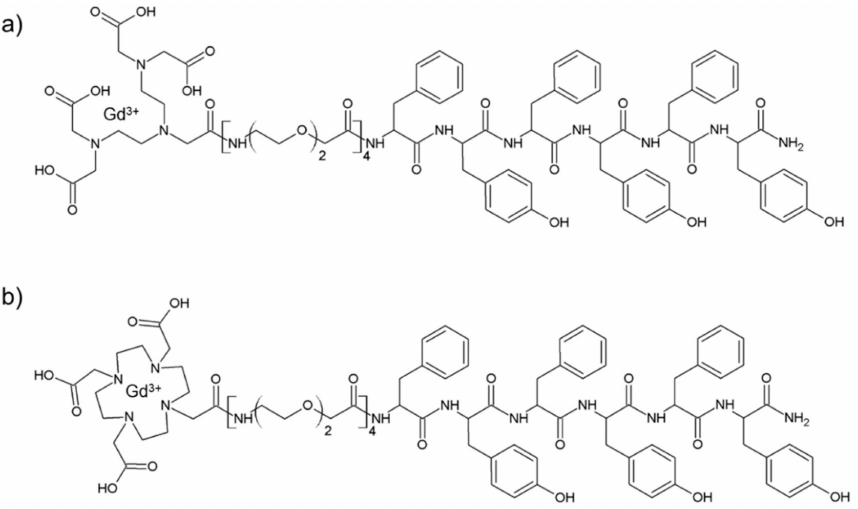
Figure 1. Schematic representation of DTPA(Gd)-PEG8-(FY)3 ( a ) and DOTA(Gd)-PEG8-(FY)3 ( b ) conjugates and structural characterization of self-assembled peptides in water solution.